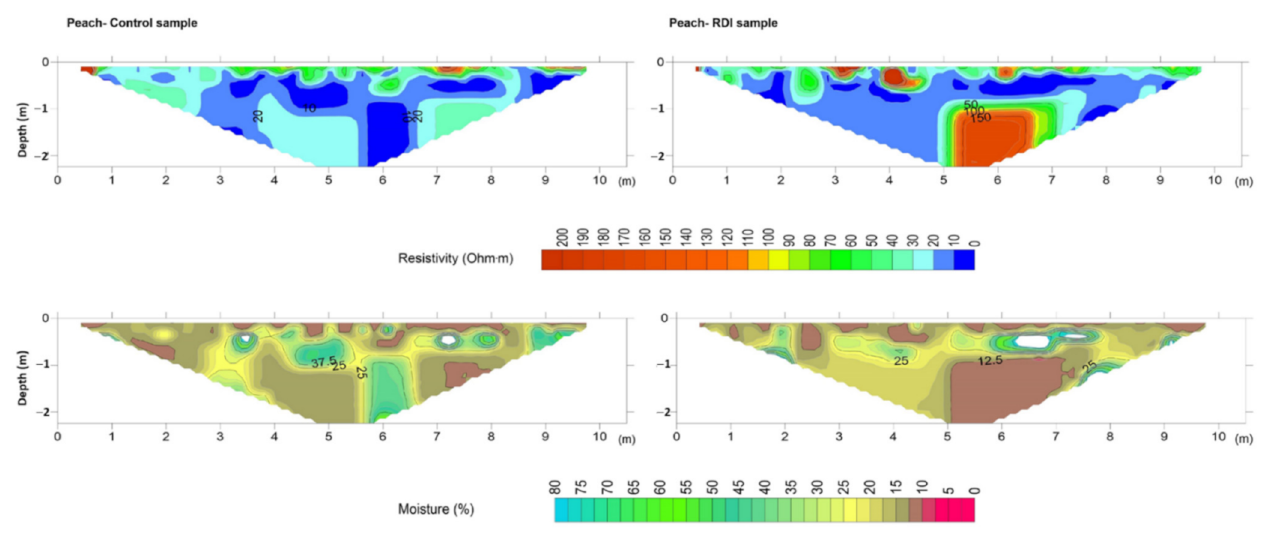
Figure 6. Resistivity model ( top ) and predicted soil moisture ( bottom ) for control ( left ) and deficit irrigation ( right ) in the peach